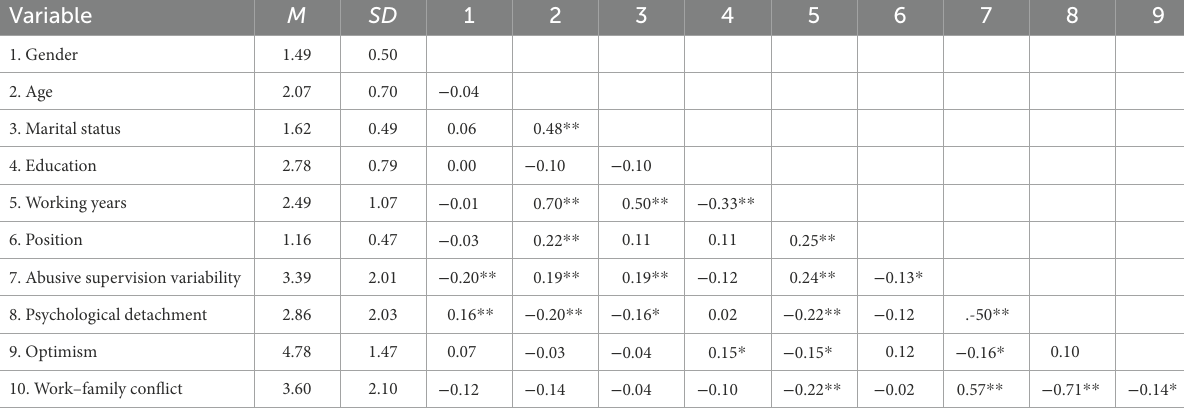
TABLE 1 Means, standard deviations, and correlations between study variables ( N = 260). Variable